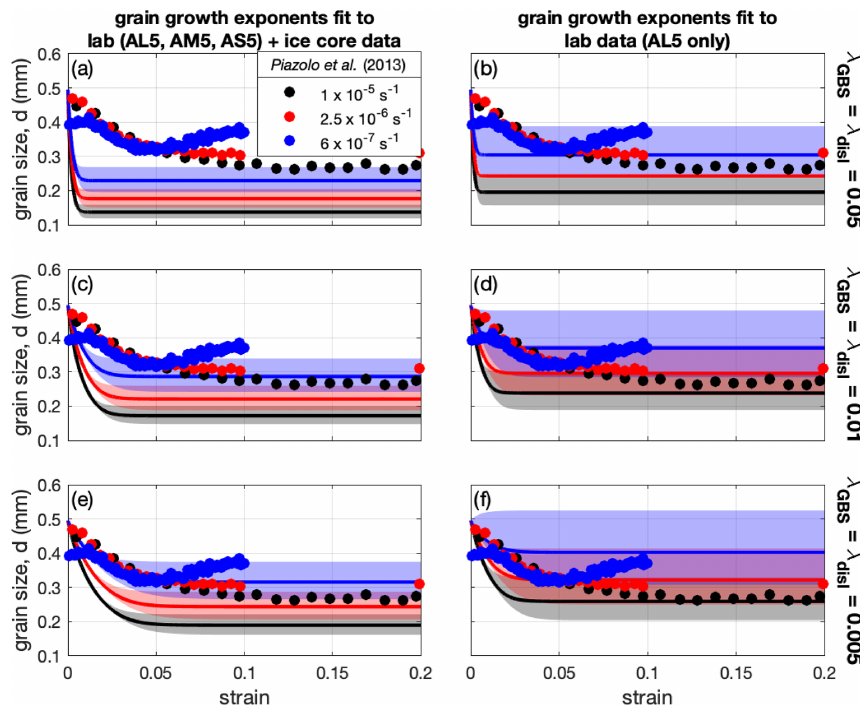
Figure 5. Comparison of wattmeter to experimental data on grain size evolution from Piazolo et al. (2013). Calculations are performed assuming a shear zone with an imposed strain rate corresponding to the laboratory experiments (1 × 10 − 5 s − 1 black; 2.5 × 10 − 6 s − 1 red; 6 × 10 − 7 s − 1 blue). Initial grain size is set to 0.5mm, and grain size evolution is calculated as a function of time and strain using Eq. (13). Panels (a) , (c) , and (e) show results using the grain growth parameters from the joint fit between the laboratory and ice core data (black line in Fig. 2); panels (b) , (d) , and (f) show results using the grain growth parameters from Azuma et al. (2012) experiment AL5. Rows indicate calculations using different values for λ = λ GBS = λ disl ranging from (a, b) 0.05, (c, d) 0.01, to (e, f)